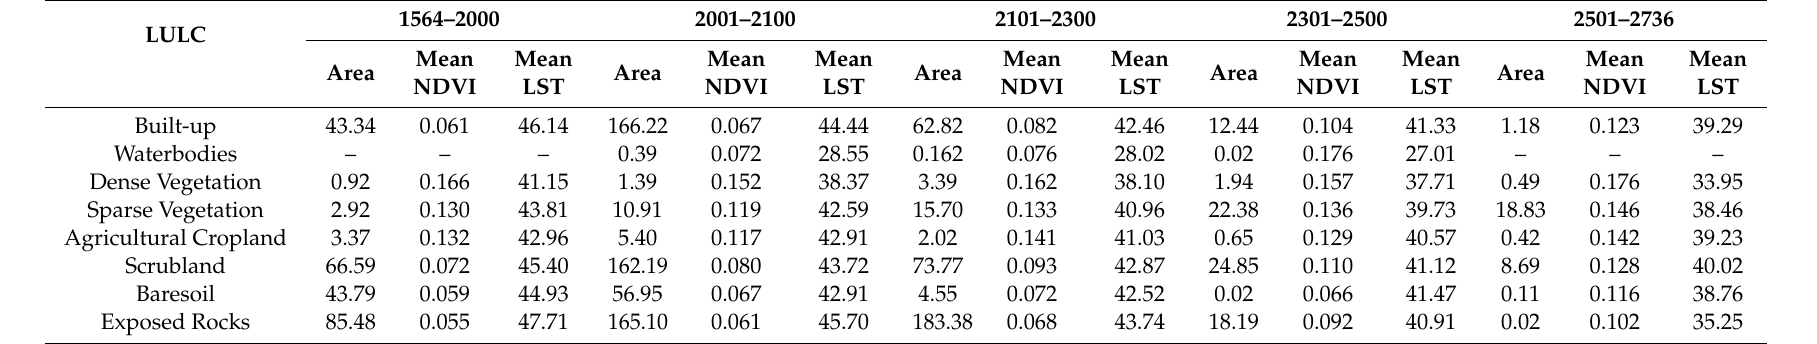
Table 3. Statistical analysis LST and NDVI over the various LULC at the classified elevation